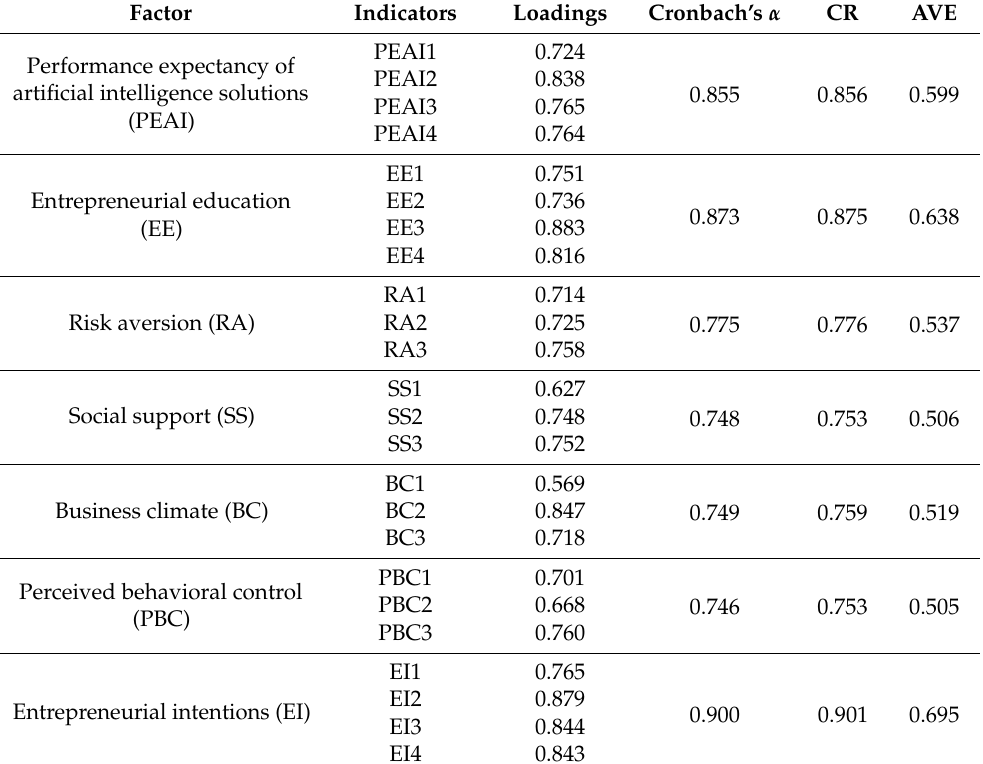
Table 1. Results for convergent validity and